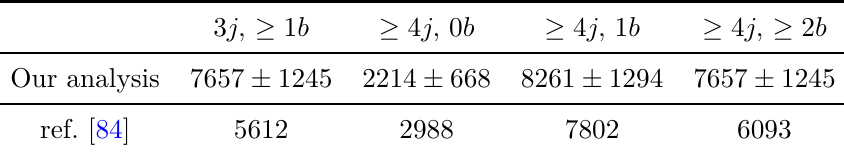
√ Table 3 . Expected number of events for tt production at s = 7 TeV and 5 . 0 fb − 1 obtained with our analysis code and by the CMS collaboration in ref. [84]. For our analysis we only show the statistical errors from the limited MC samples we used, whereas the errors in the numbers of ref. [84] are dominated by systematic uncertainties, which amount to roughly